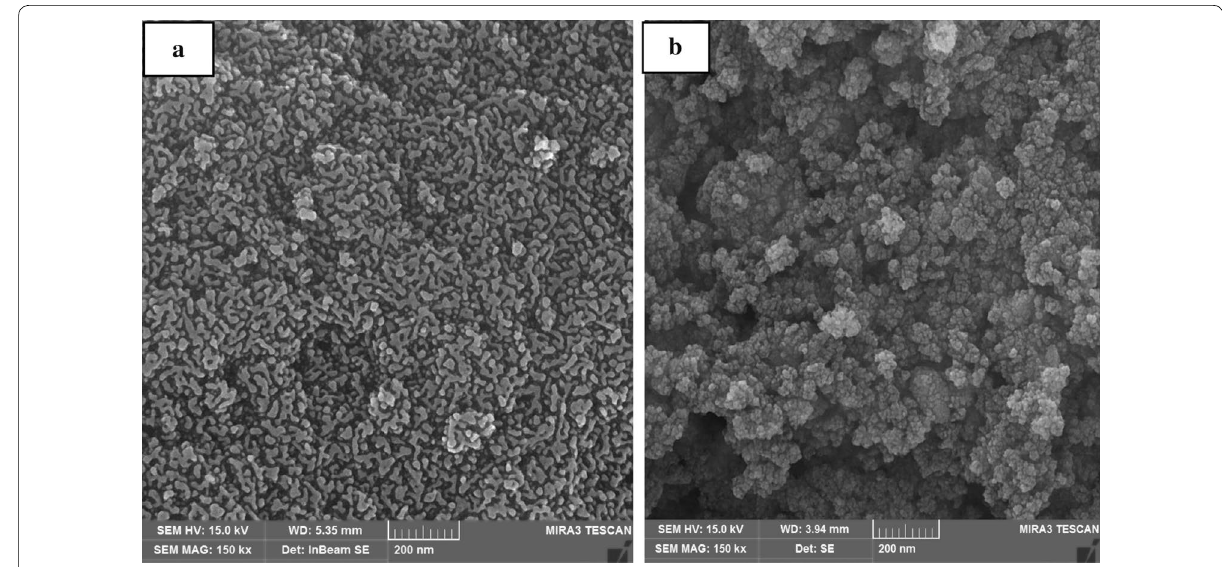
Fig. 1 The results of SEM images of a Fe 3 O 4 nanoparticles and b Fe 3 O 4 /SiO 2 /TiO 2